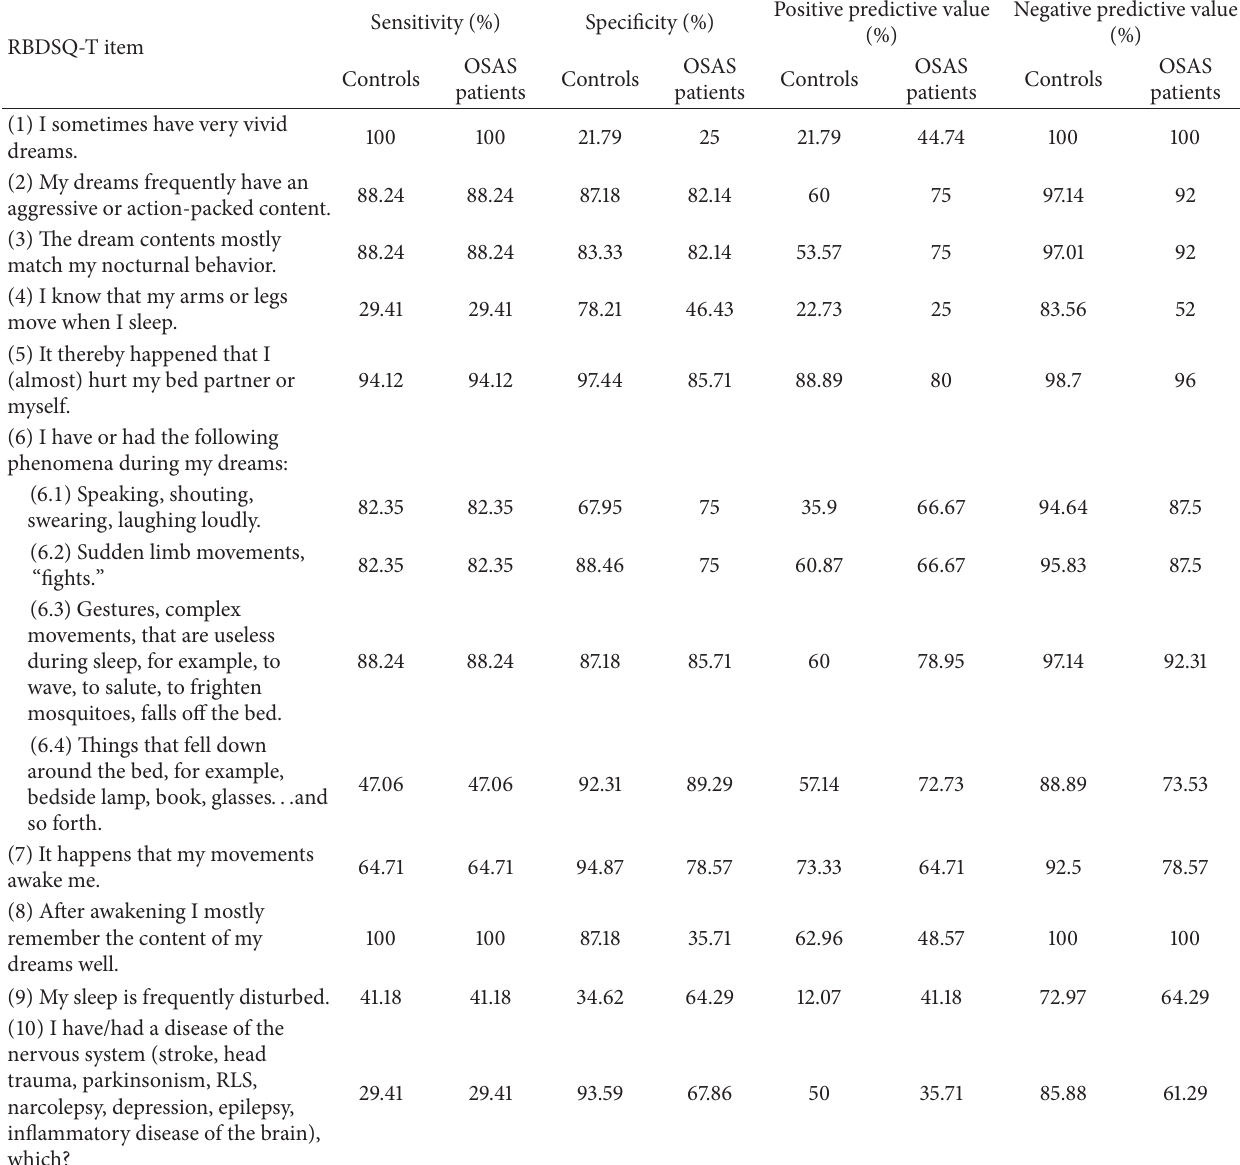
Table 3: Sensitivity and specificity of the Turkish version of the rapid eye movement sleep behavior disorder questionnaire